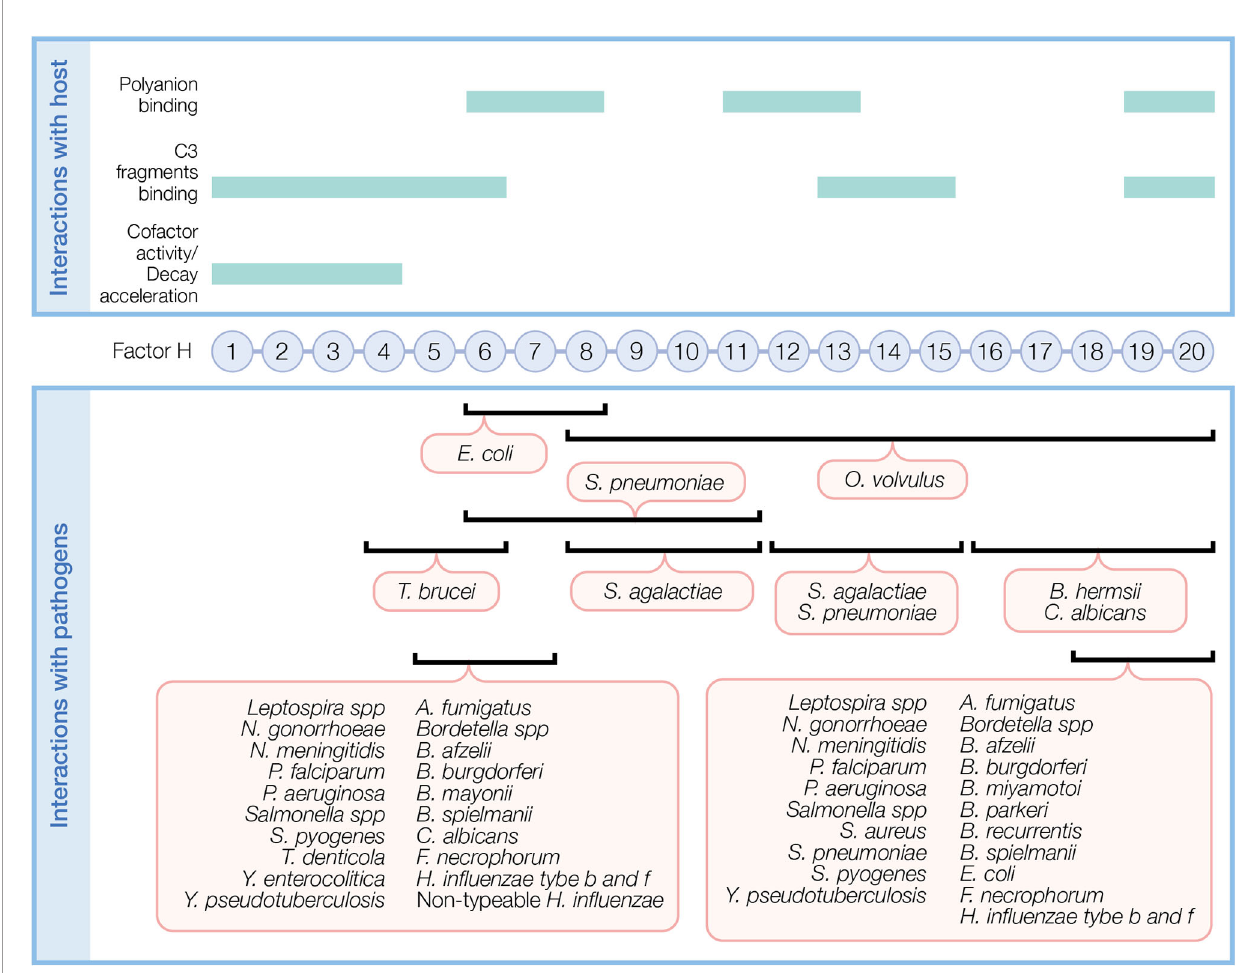
FIGURE 2 | Factor H domains involved in binding to the host and pathogens. FH contains 20 complement control protein modules (CCP) each with about 60 amino acids linked by three to fi ve amino acids. In the top panel, FH domains necessary for its regulatory function and domains interacting with C3 fragments and polyanions are indicated. In the bottom panel, overlapping FH domains involved in binding pathogens are indicated. Refer to Table 1 for speci fi c FH domains involved in binding to individual pathogens and for pathogens binding FH through unde fi ned